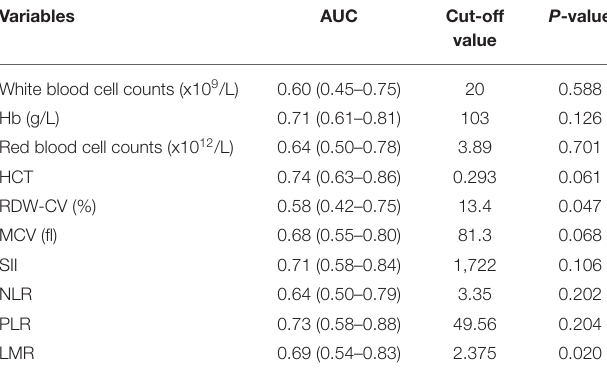
TABLE 2 | Receiver operating characteristic curve analyses of the blood test-based parameters.